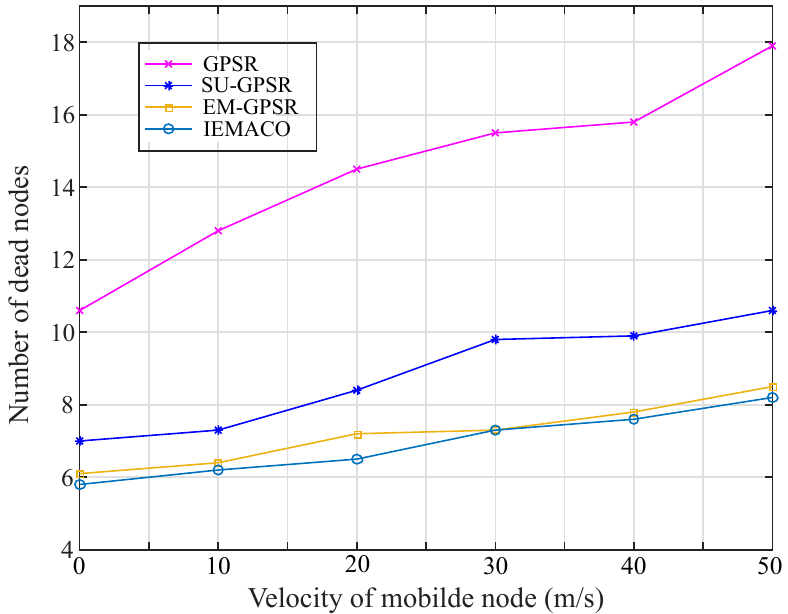
Figure 11. Number of dead nodes versus the velocity of a mobile node.